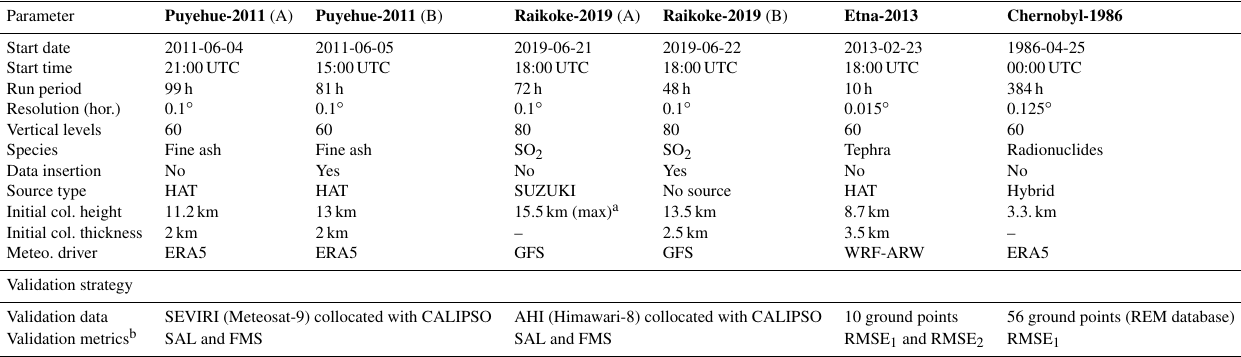
Table 1. Summary of model setups for the test suite validation cases shown in this paper.